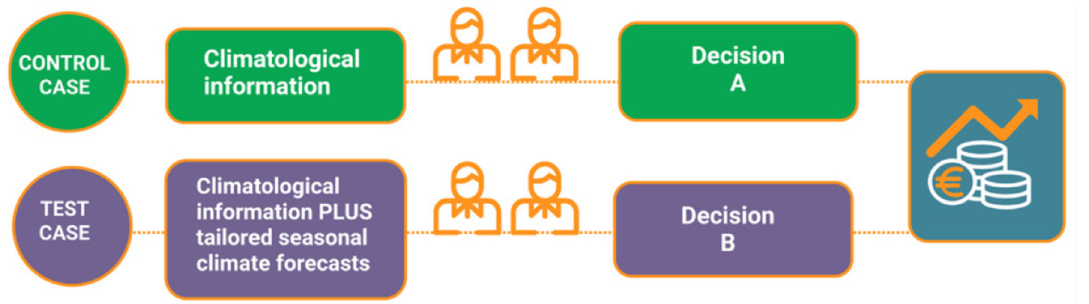
Figure 1. The twin experimental approach to assess the value-add adopted in SECLI-FIRM using a climatological baseline (control case) augmented by seasonal forecasts (test case).